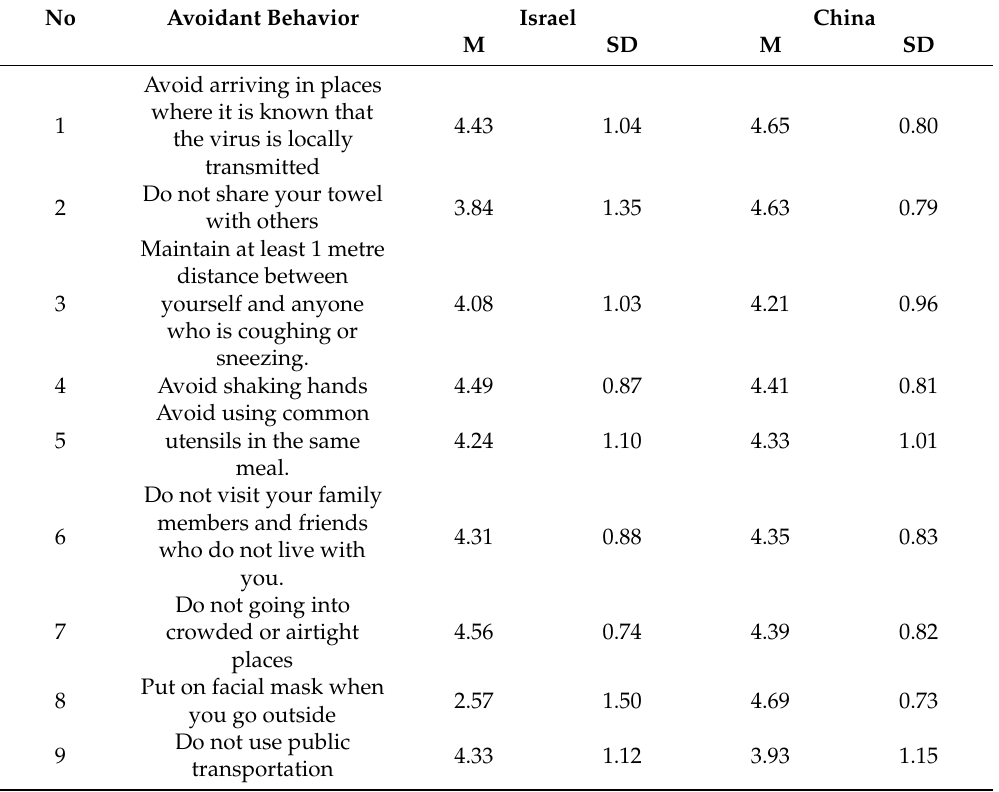
Table 5. descriptive statistics for avoidant